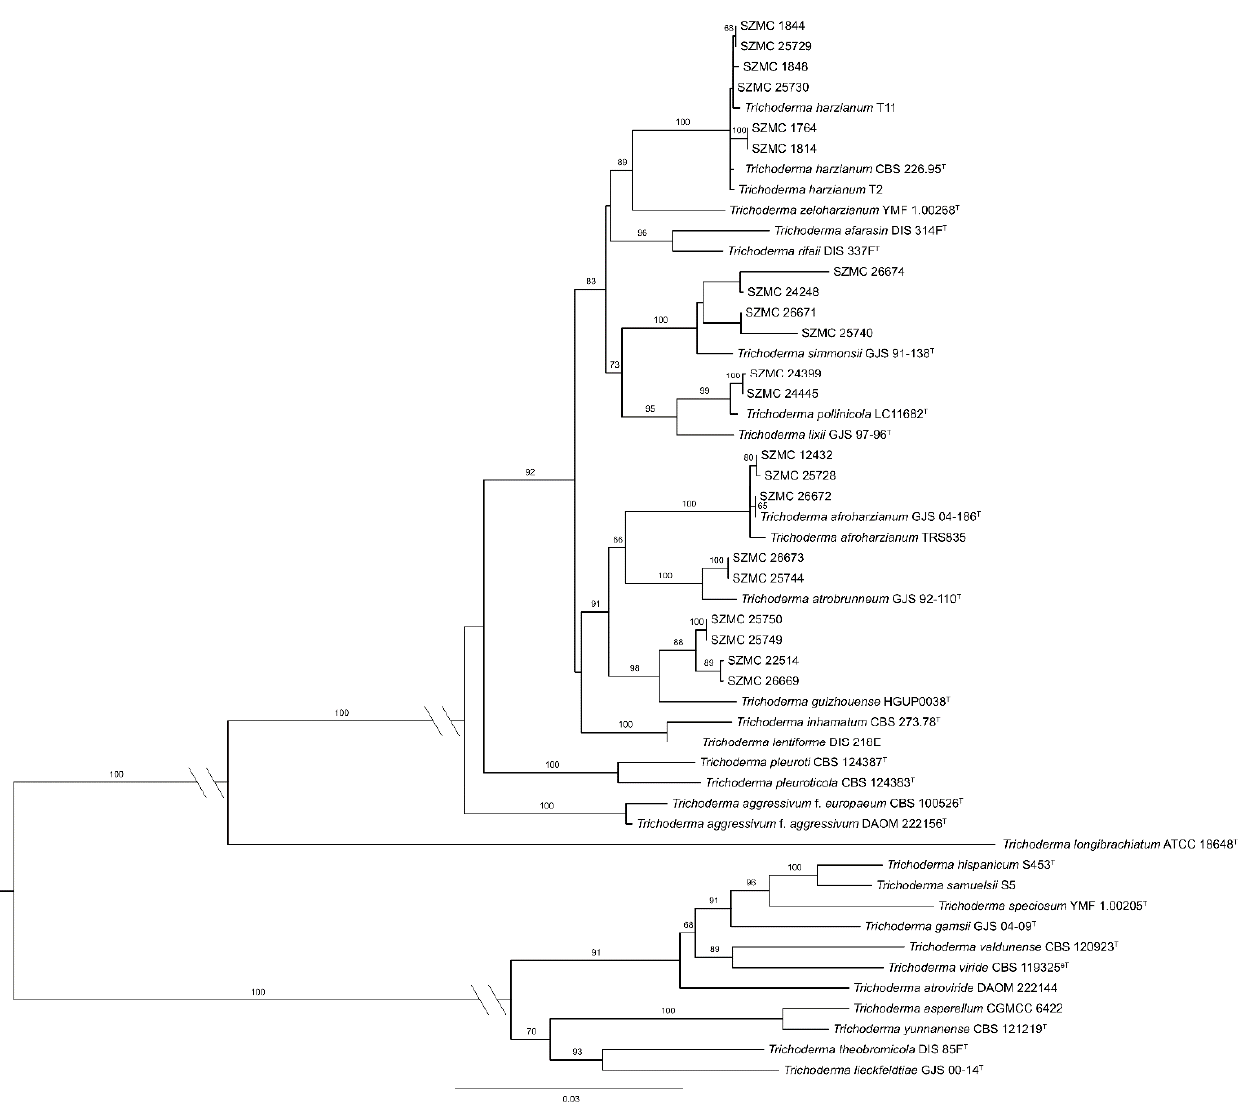
Figure 1. Maximum likelihood phylogenetic analysis of Trichoderma strains isolated from mushroom growing facilities based on the concatenated translation elongation factor 1-alpha ( tef1 ), internal transcribed spacer (ITS), second largest subunit of RNA polymerase II ( rpb2 ), and calmodulin ( cal1 ) sequences. T = ex-type, eT = ex-epitype. Numbers above branches are bootstrap values. Only values higher than 70% are shown.